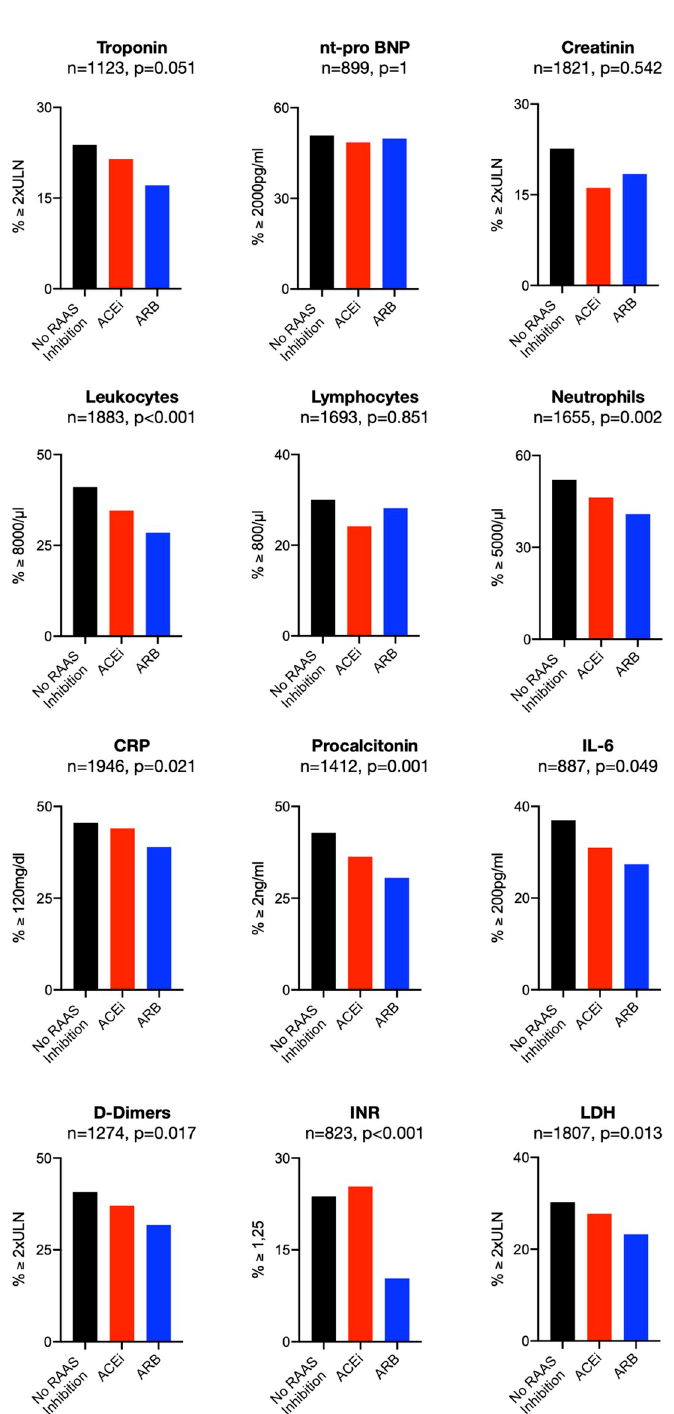
Fig 4. Biomarkers in all patients with CVD/Hypertension. Percentage of patients above the mortality predicting threshold for biomarkers calculated by ROC analysis in all patients with cardiovascular disease or hypertension irrespective of disease phase at baseline for patients without RAAS-modulation, patients on ACE-inhibitors and patients taking ARBs. n-numbers and p-values are depicted above each panel.